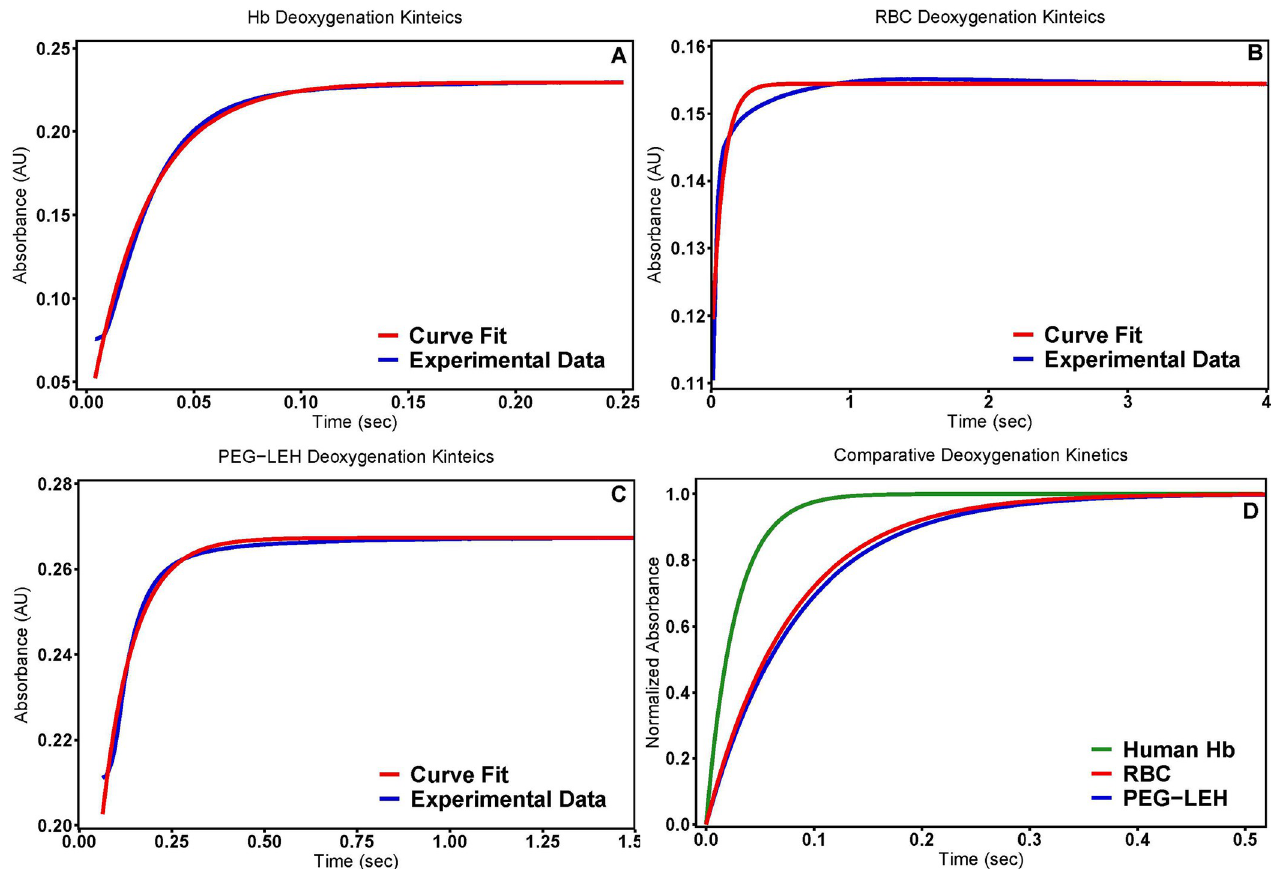
Fig 4. Deoxygenation kinetics. Time courses for deoxygenation of human (A) Hb, (B) RBCs, and (C) PEG-LEH nanoparticles were collected in the presence of 1.5 mg/mL sodium dithionite. The experimental data shows an average of 10–15 kinetic traces. D) The normalized absorbance of the experimental fit for the three groups is shown as a direct comparison of the deoxygenation kinetics. The reactions were monitored at 437.5 nm and 20˚C. PBS (0.1 M, pH 7.4) was used as the reaction buffer.